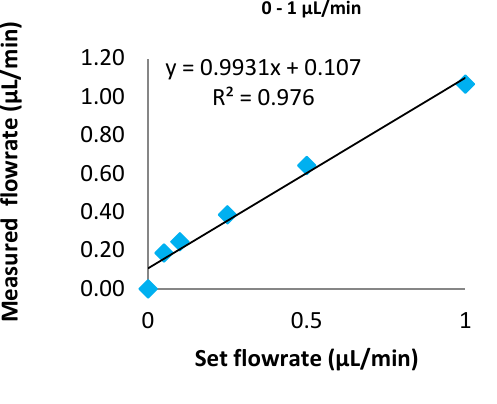
Figure 2. Average flow rates in a range from ( left ) 0–1.0 µL/min and ( right ): 0–10 µL/min.